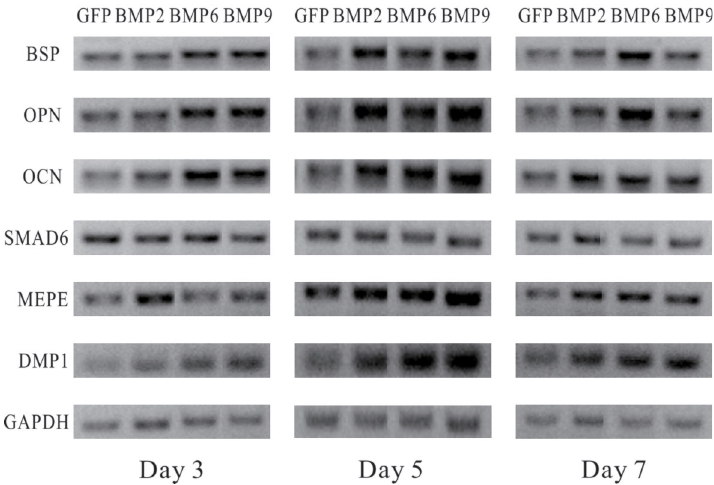
Figure 2. Representative results of semi-quantitative RT-PCR analysis of osteogenesis-related genes in immortalized preodontoblasts (iPDBs) upon bone morphogenetic proteins (BMPs) stimulation. Relative expression level was calculated and standardized with endogenous GAPDH expression levels. Each assay was done in triplicate. GFP: green fl uorescent protein; BMP: bone morphogenetic protein; BSP: bone sialoprotein; OPN: osteopontin; OCN: osteocalcin; MEPE: matrix extracellular phosphoglycoprotein; DMP1: dentin matrix protein 1.